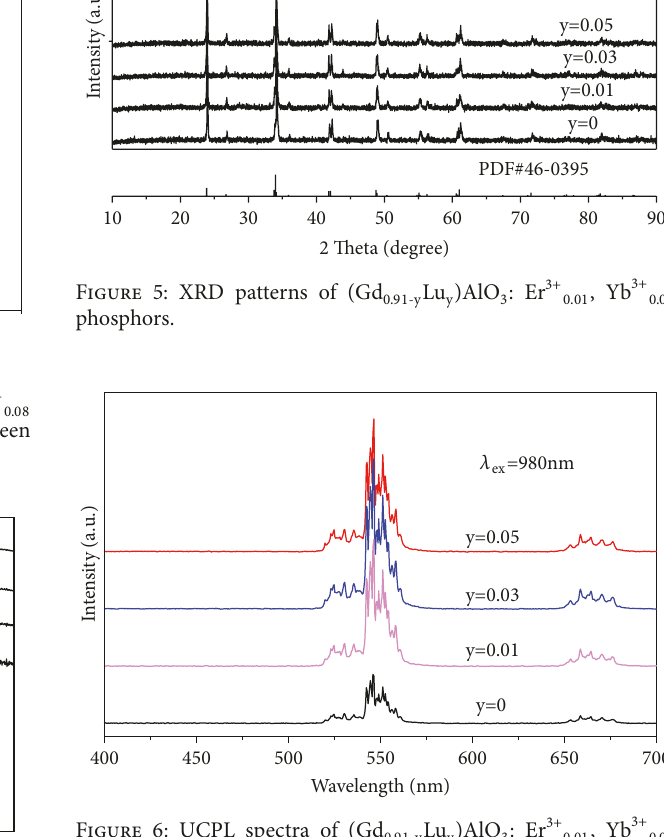
Lu y )AlO 3 : Er 3+ 0.01 , Yb 3+ 0.08 - y